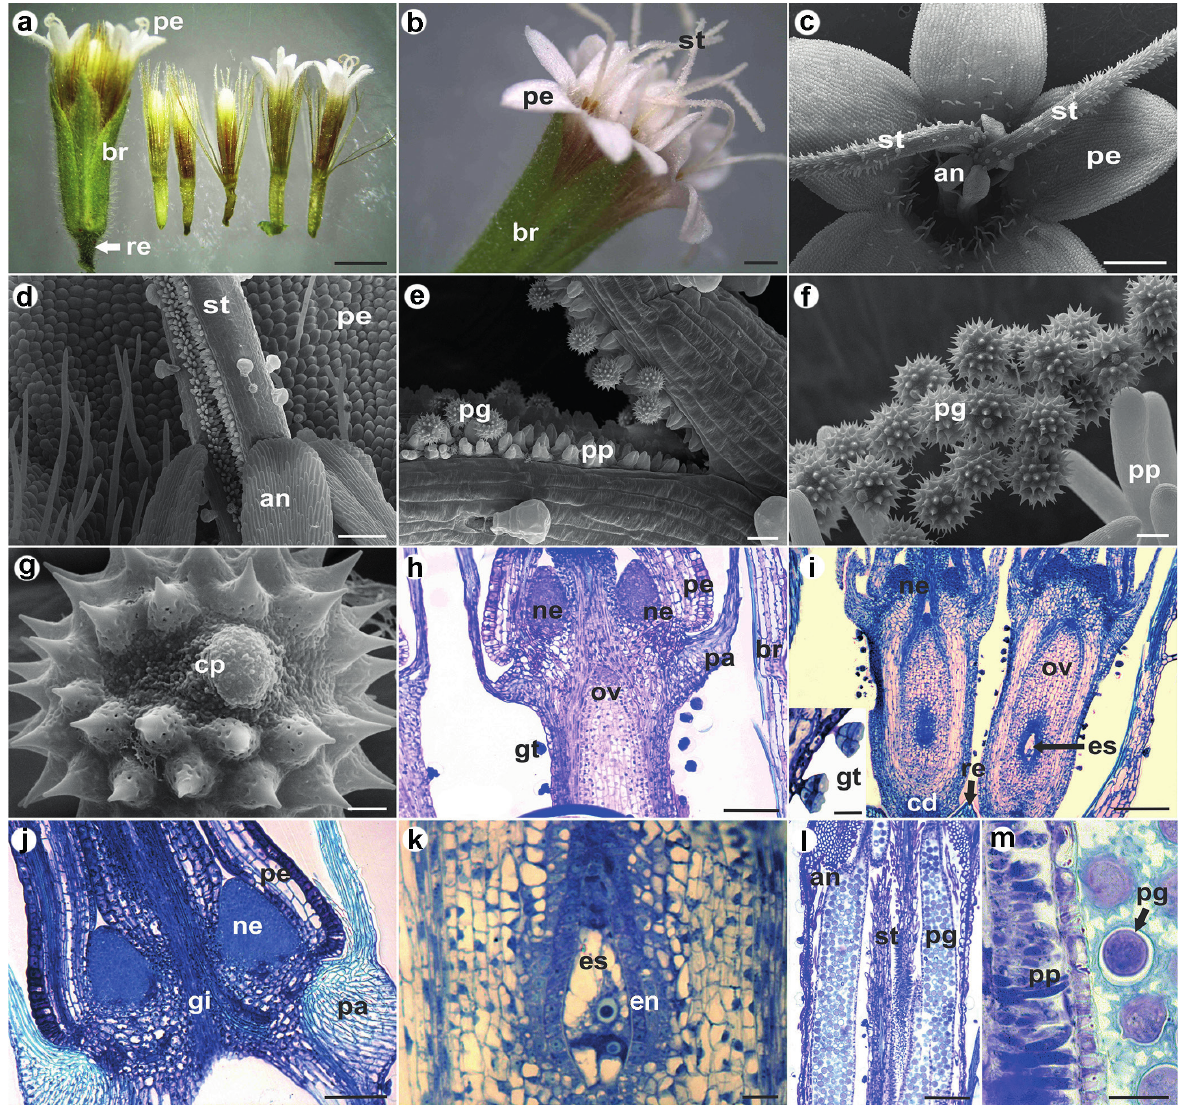
Figure 3 - Floral morphology of Stevia rebaudiana (Asteraceae). a-b ) General view of capitula with florets in different stages of development. c-g ) Morphological studies under scanning electron microscopy. h-l ) Anatomical aspects observed under light microscopy. c ) Floret details showing the pentamerous corolla, connate anthers and stigma branches; d ) Detail of petals, anthers and stigma; e-f ) Stigmatic surface with pollen grains adhered to the papillae; g ) Pollen grain showing the colpore region and spines with perforated base; h ) The distal region of the ovary, with the pappus insertion, petals, and nectaries; i ) General aspect of the unilocular ovary and carpopodium, with a detail of glandular trichomes on the ovary wall epidermis; j ) Detail of the nectaries, petals, and pappus insertion. k ) Detail of the embryo sac and endothelium; l ) Anthers filled with pollen grains and the stigma branches in the center; m ) a detail of papillae and pollen grains (arrow). an: anther; br: bract; br: involuncral bracts; cd: carpopodium; cp: colpore; en: endothelium; es: embryo sac; gi: ginophore; gt: glandular trichome; ne: nectary; ov: ovary; pa: pappus; pe: petal; pg: pollen grain; pp: papillae; re: receptacle; st: stigma. Bars: a = 0.5 cm; b, h = 100 μm; c = 20 μm; d, f = 10 μm; e, m = 20 μm; g = 2 μm; i, j, l = 200 μm (detail = 25 μm); k = 50